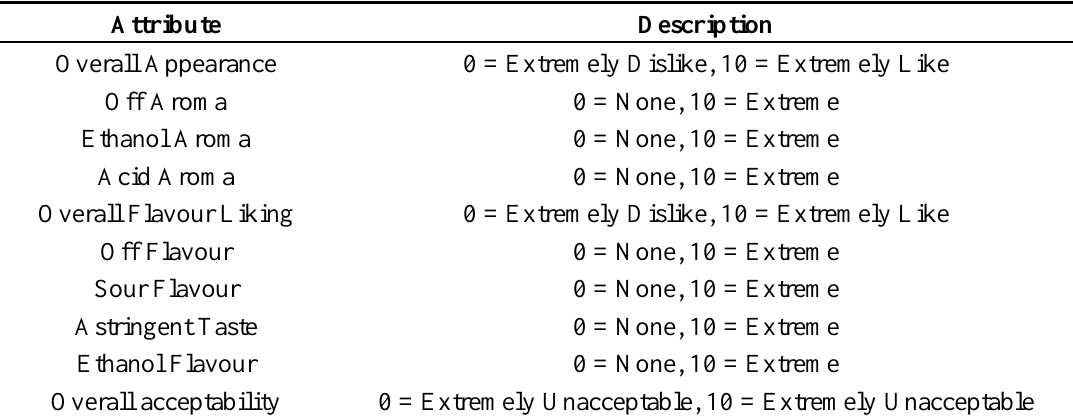
Table 2. List of descriptors for sensory analysis.